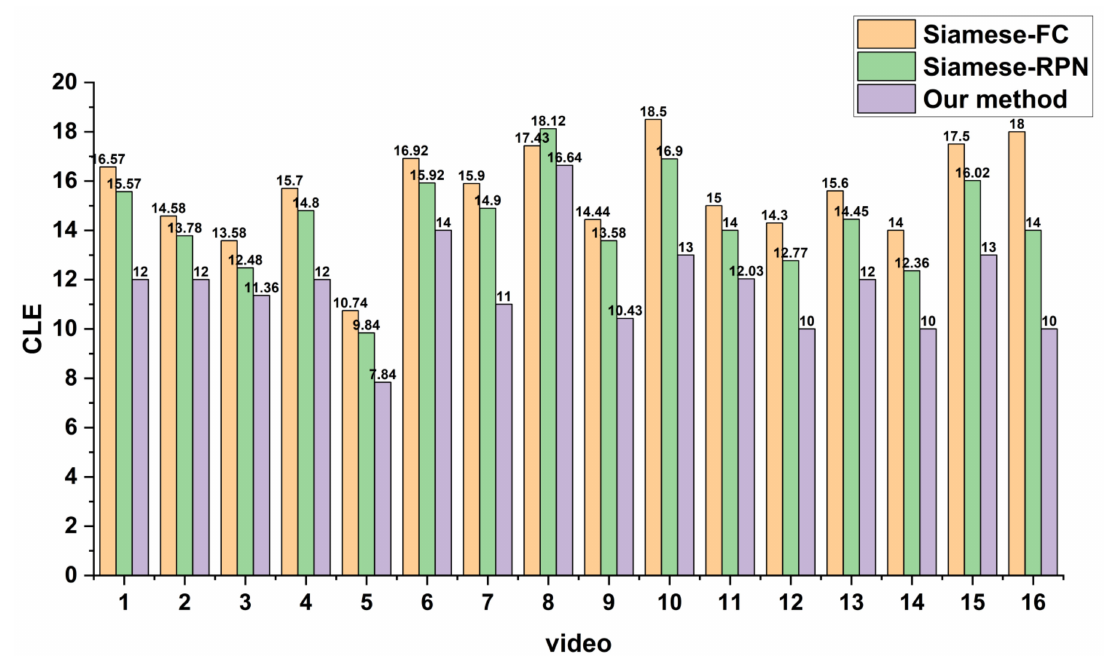
Figure 20. CLE comparison of the three methods.